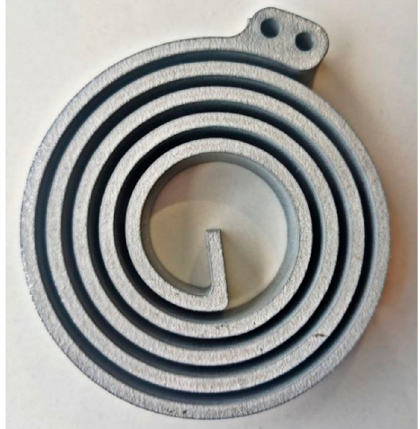
Figure 15. Manufactured spiral